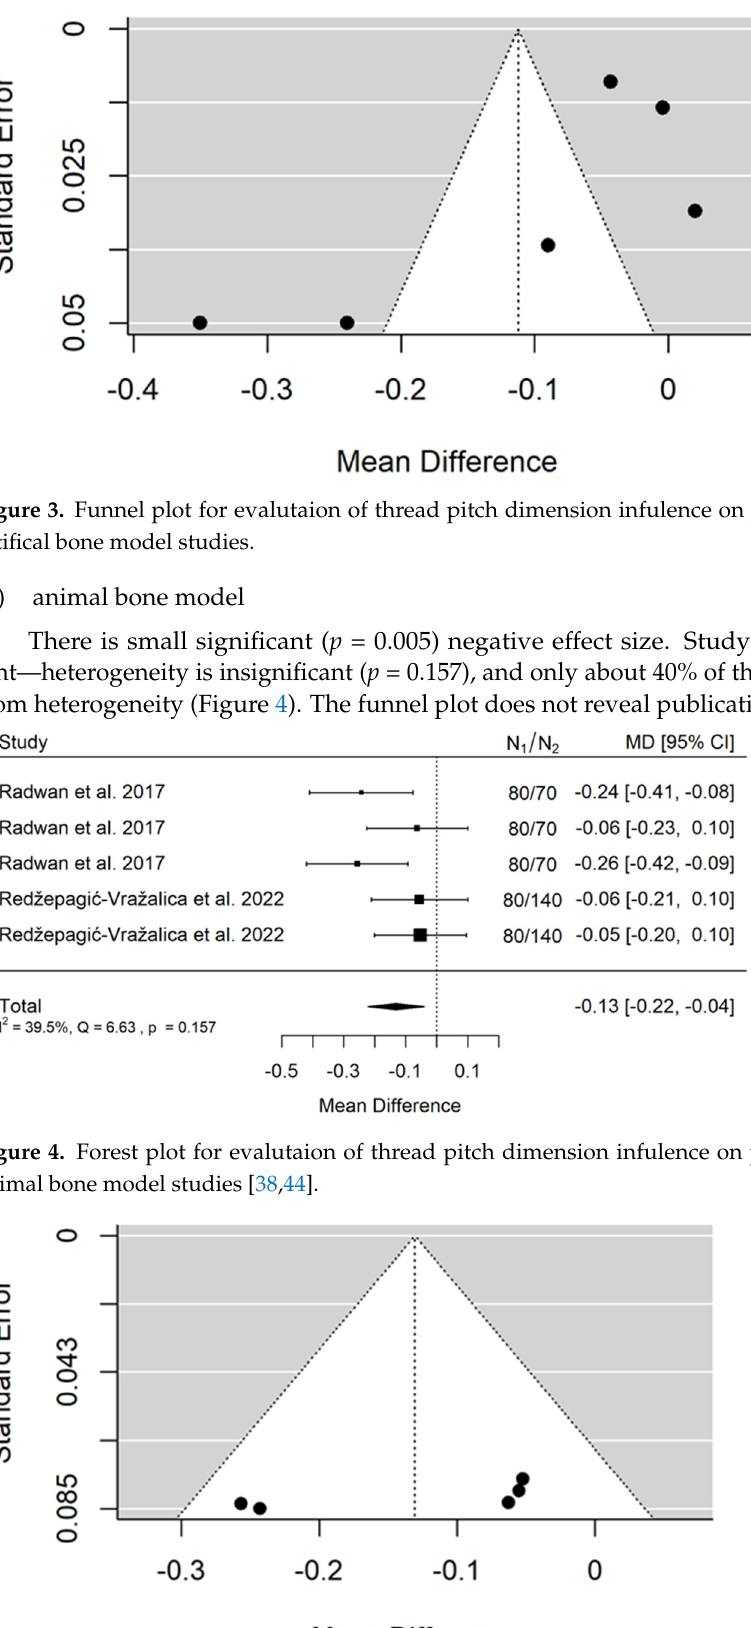
Figure 2. Forest plot for evalutaion of thread pitch dimension infulence on pull-out strentght in artifical bone model studies [33,34,41].